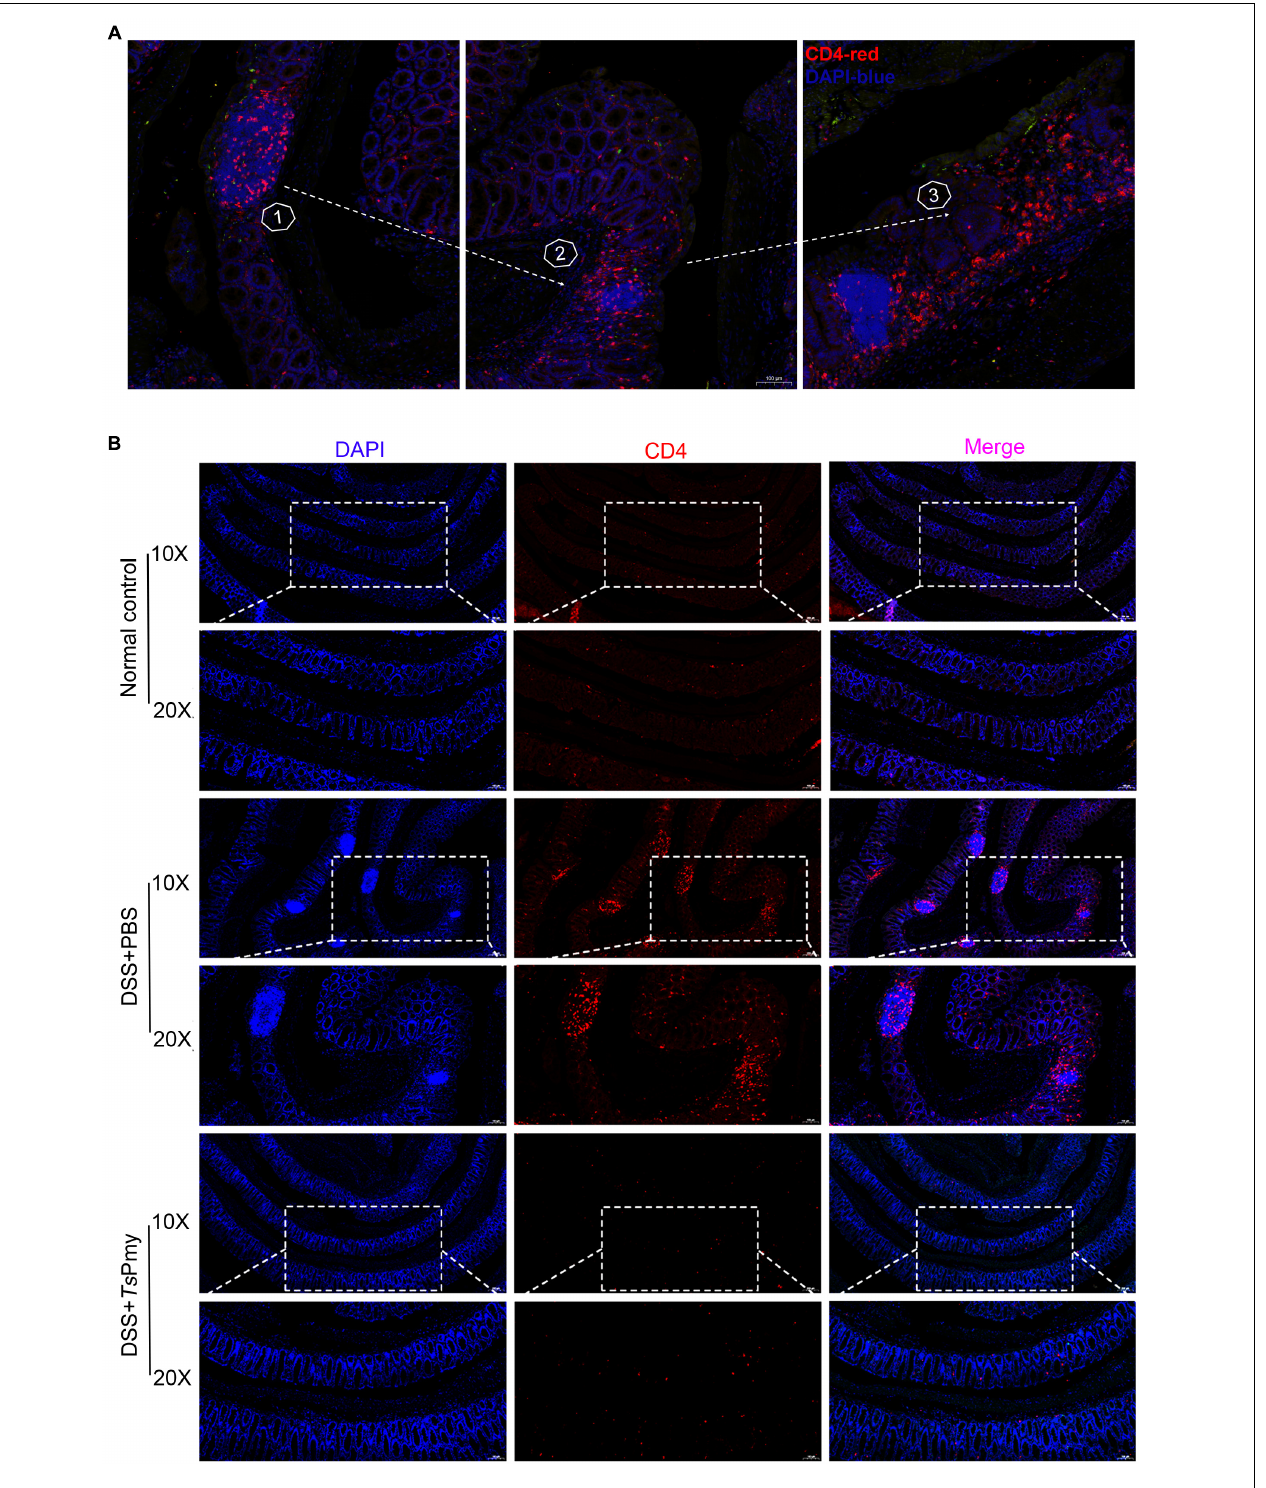
FIGURE 3 | Treatment with r Ts Pmy reduces the recruitment of CD4 + effector cells in the isolated lymphoid follicles of mice with DSS-induced colitis. Immunofluorescent staining of the distal colon sections with antibodies for CD4 (red), counterstained with DAPI (blue). (A) Pathological process of DSS-induced colitis with increased recruitment of CD4 + effector cells in ILFs. Foxp3 eGFP mice were used. (B) Distal colon sections of mice from different groups on day 5. Illustrations are representative of 3 mice per group. ILFs, isolated lymphoid follicles.